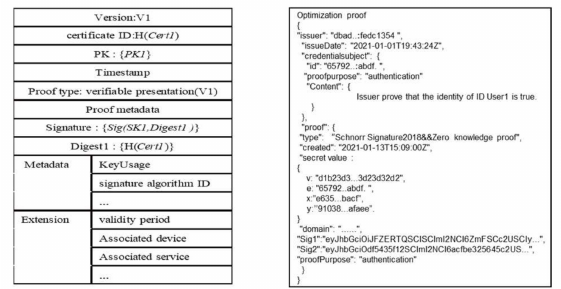
Figure 2. An example of a self-signed certificate and